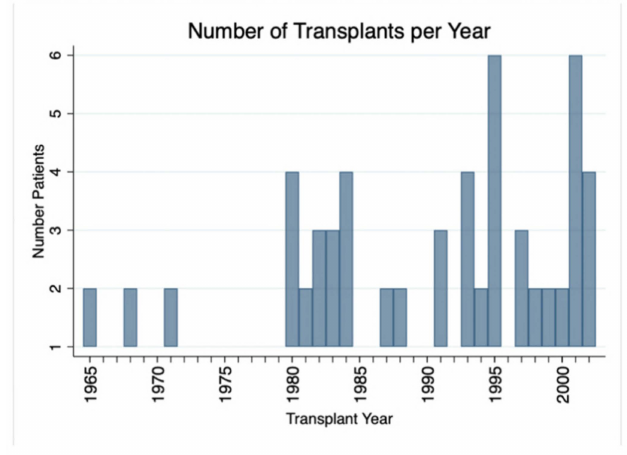
Figure 1. Distribution of transplants by date. Genetically identical transplants were performed between 1965 and 2002.